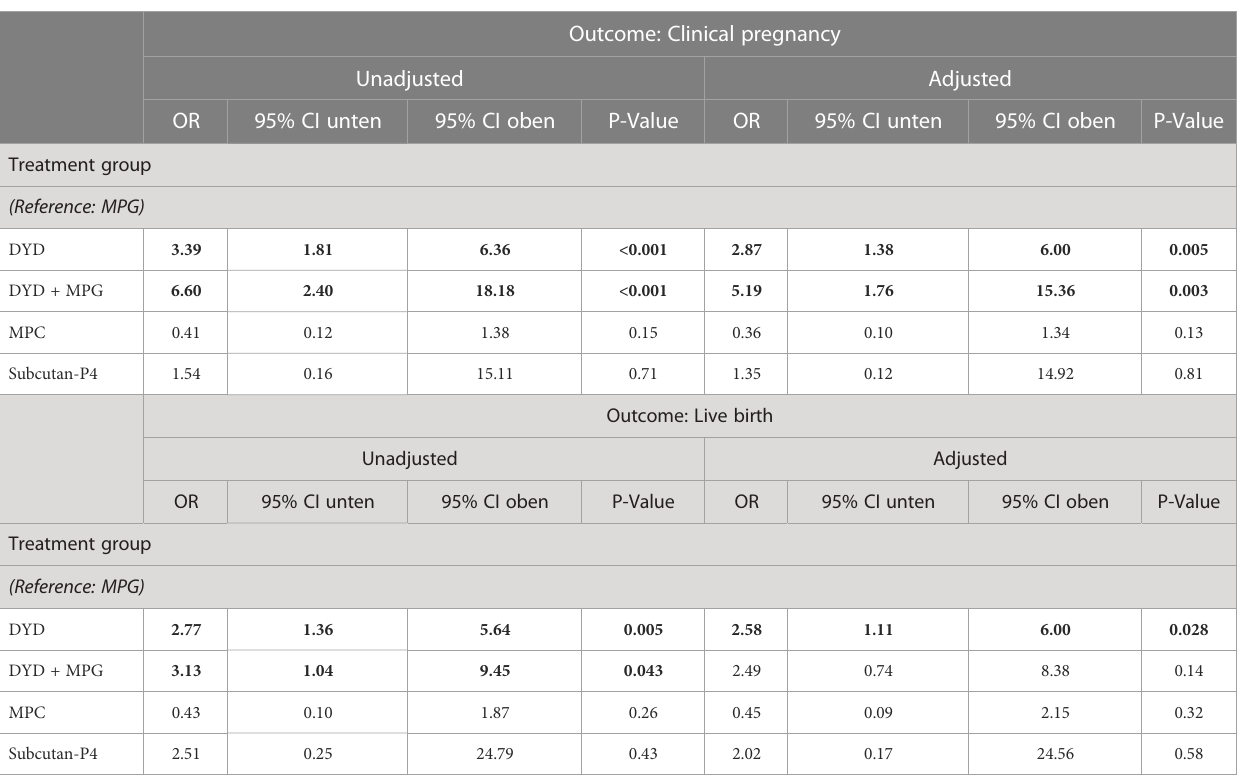
TABLE 3 Primary outcomes: multiple logistic regression analyses of clinical pregnancy and live birth